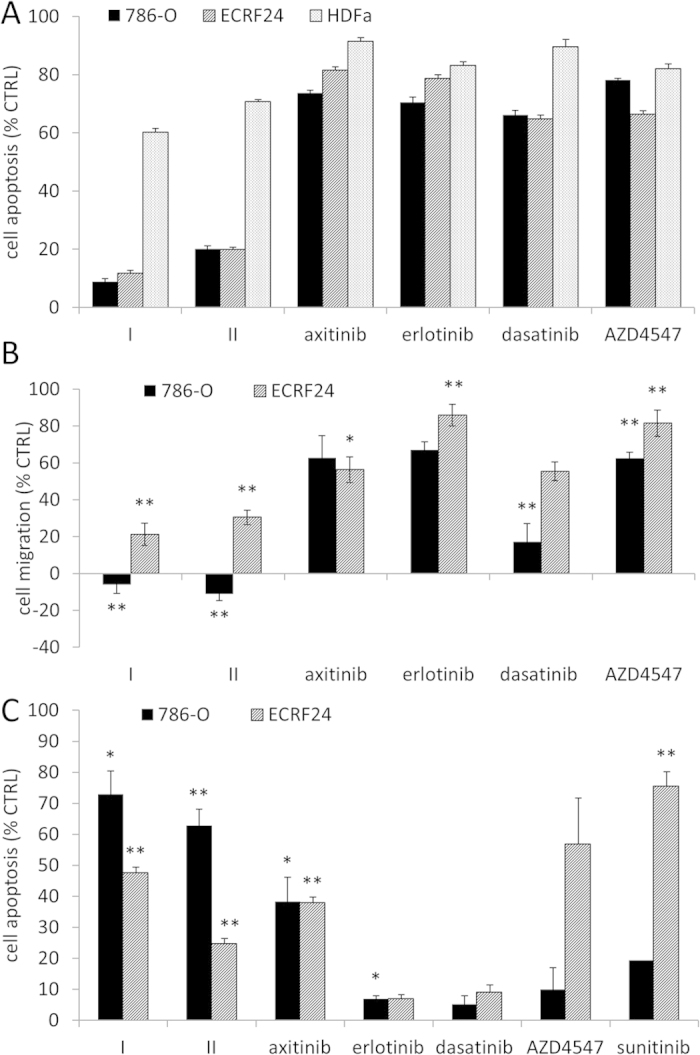
Summary of the data used to validate the optimized drug combinations I and II.(A) The effects of the most promising drug combinations I and II, refer to Fig. 4A, and their corresponding monotherapies were tested on the viability of the following non-malignant cell lines: immortalized human endothelial cells (ECRF24), and adult human dermal fibroblasts (HDFa). (B) Migration inhibition of ECRF24 and 786-O cells with corresponding monotherapies. (A,B) Values represent the mean of at least 2 independent experiments, with 3 replications each. Error bars represent the SEM. (C) The effects of individual compounds and combinations on ECRF24 and 786-O cell apoptosis induction. Values represent the mean of at least 2 independent experiments and error bars represent the SEM. Asterisks represents significance tested by the student’s t-test, *p < 0.05 and **p < 0.01.